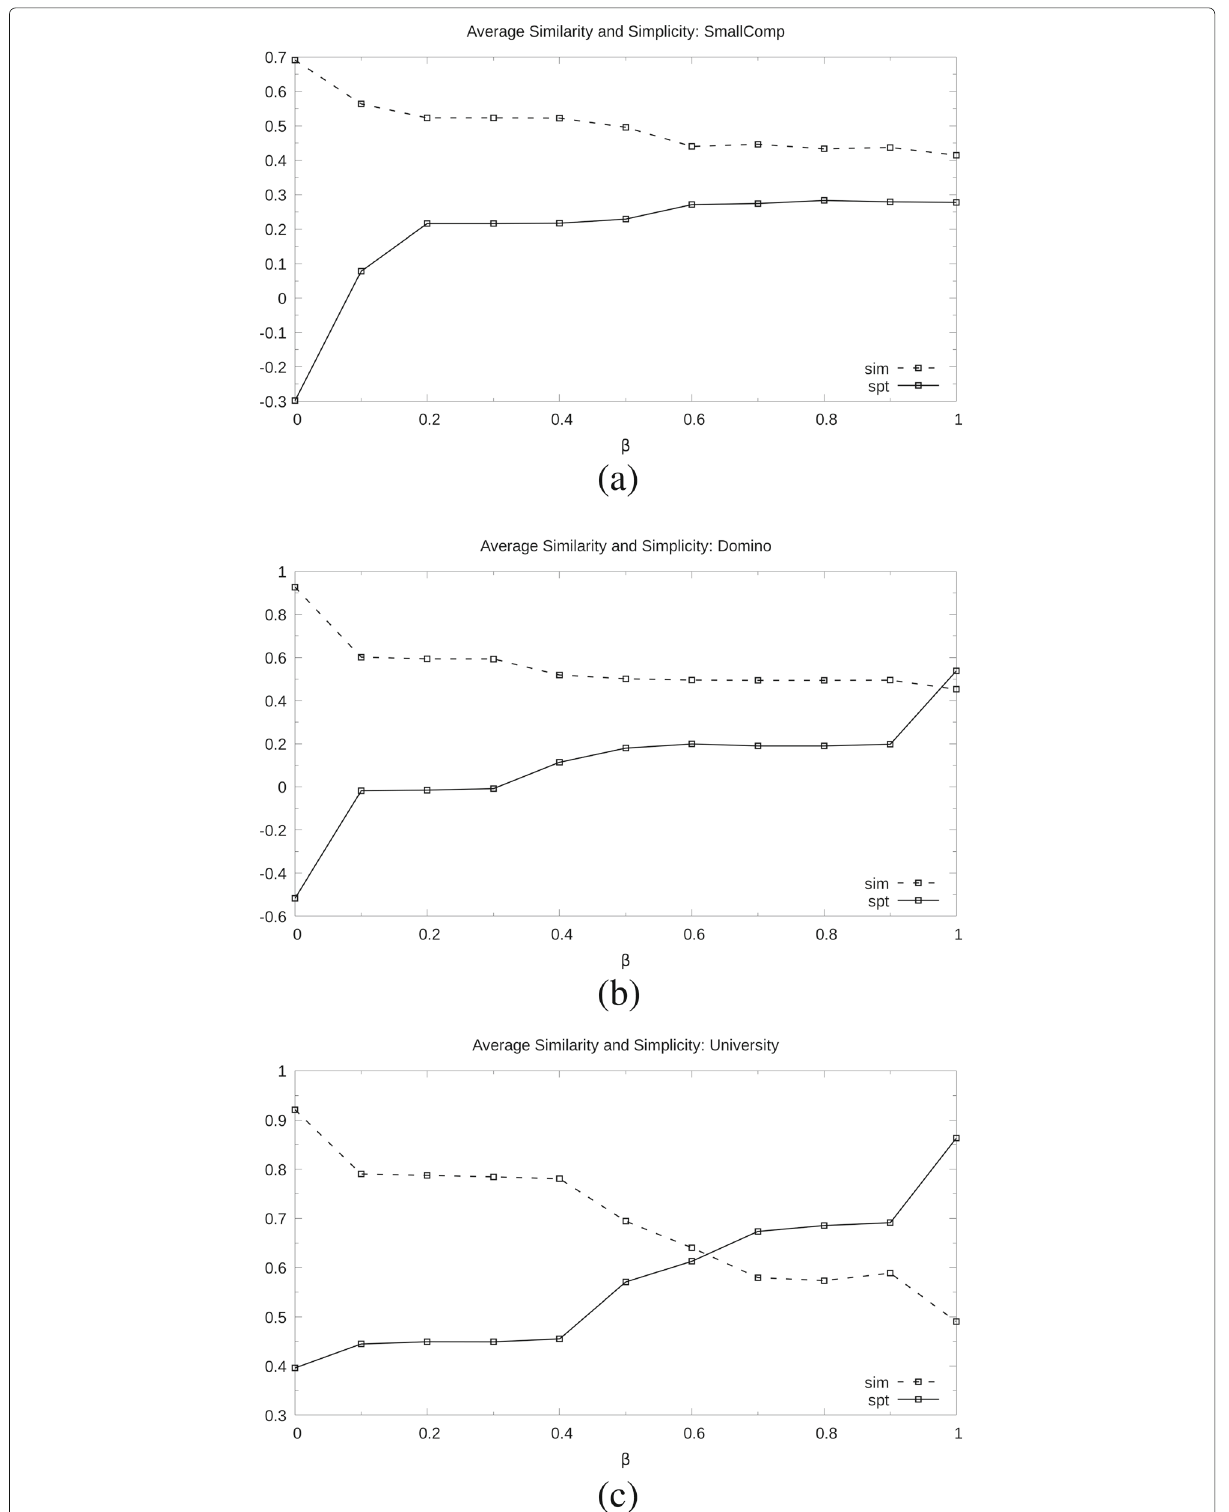
Fig. 9 Average similarity and simplicity ( y axis) as a function of the balance β ( x axis) for multiple exceptions and violations to ( a ) SmallComp , ( b ) Domino and ( c ) University dataset. Twenty-one values of β ∈ [0,1] are sampled, at regular intervals (step